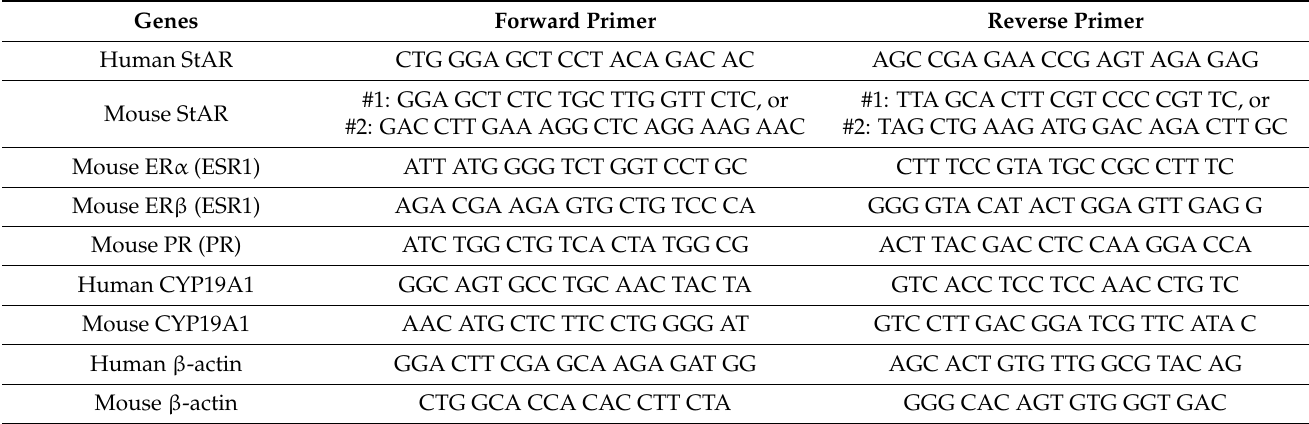
Table 1. Primers used for RT-PCR and/or RT-qPCR for analyzing expression of different genes. Forward